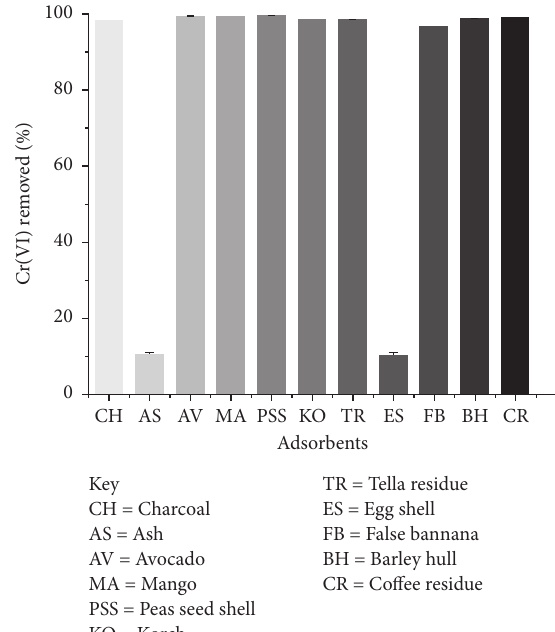
Figure 4: Screening of adsorbents for Cr(VI) removal (conditions: initial concentration of Cr(VI) 5mg/L, adsorbent dose 2.5g/L, pH 2, contact time 24h, shaking speed 200 rpm, and temperature 25 ° C).